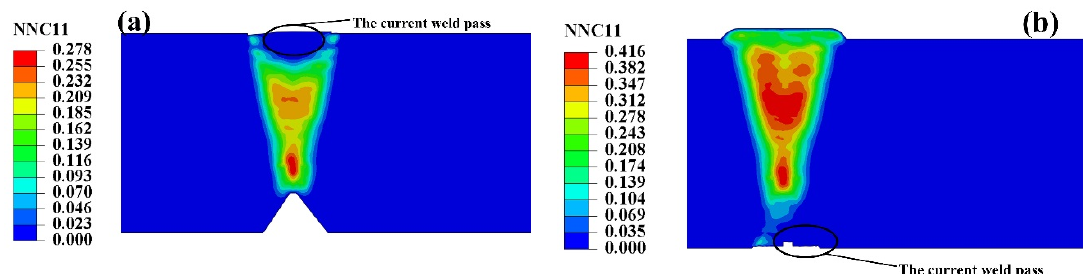
Figure 17. Activity distribution in welding process of heavy plate: ( a ) Front weld; ( b ) Back weld.